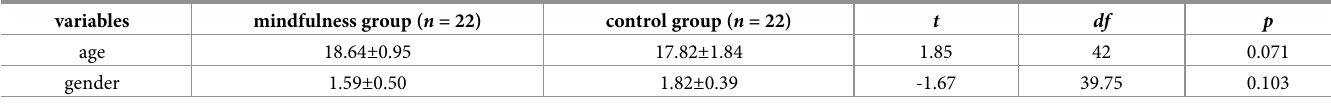
Table 1. Descriptive statistics and independent sample t-test comparison of the demographic variables. variables